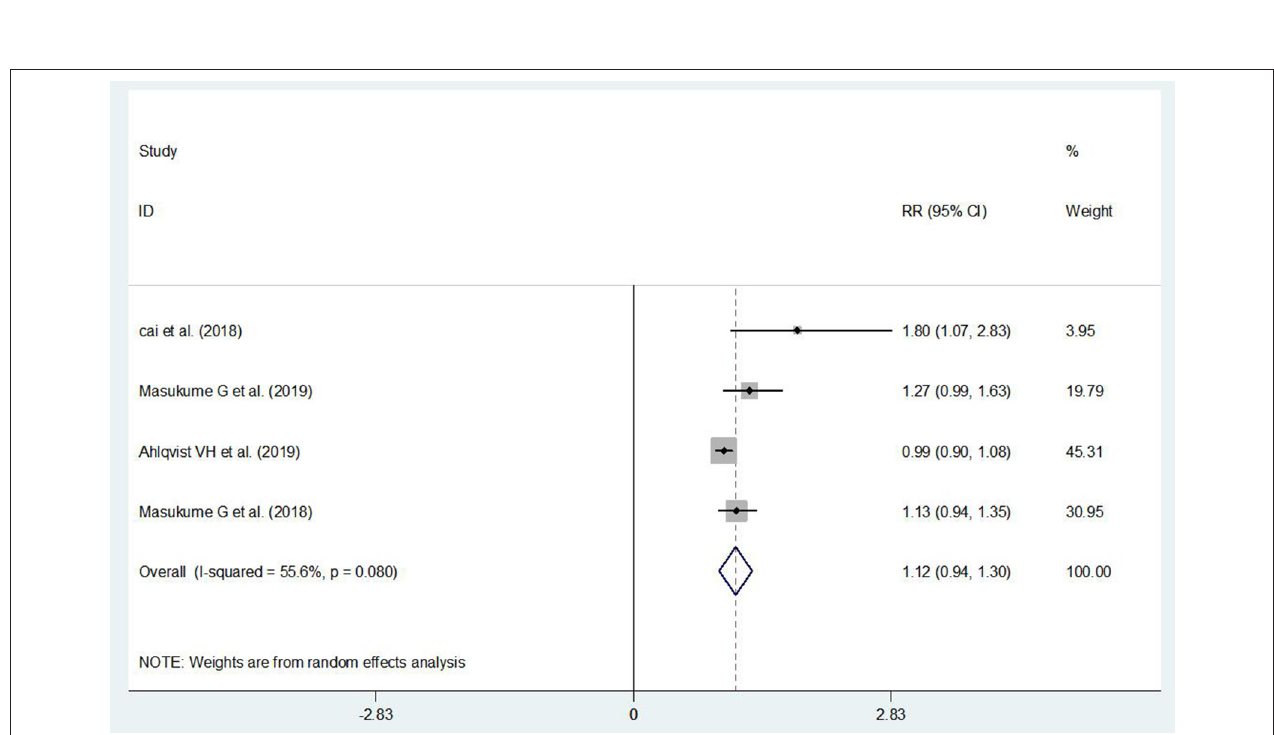
FIGURE 3 | The association between ECS and children’s